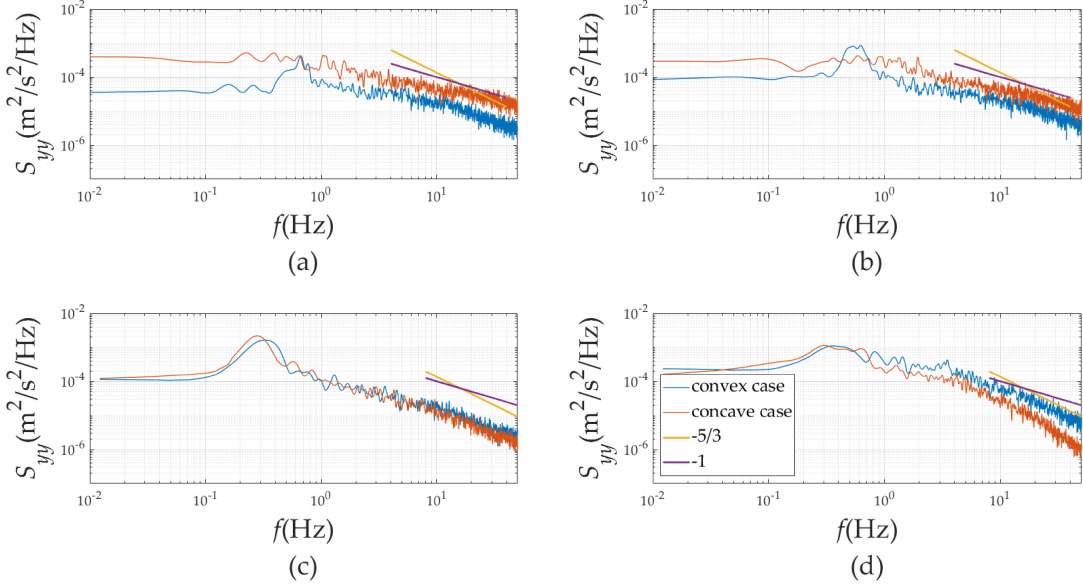
Figure 9. Effect of vegetation density on turbulent spectrum: ( a ) φ = 2.235% at the 90 ◦ section; ( b ) φ = 2.235% at the 135 ◦ section; ( c ) φ = 4.47% at the 90 ◦ section; ( d ) φ = 4.47% at the 135